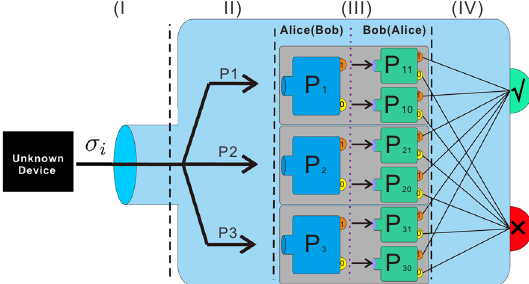
Fig. 1 Diagram of adaptive QSV with LOCC. The fi gure represents the general procedure to implement an adaptive QSV to verify whether an unknown source generates a pure target state. The generated states σ 1 , σ 2 , σ 3 , … , σ n are projected fi rstly by Alice with a randomly selected measurement setting Π i , with a prior probability as P i . The measurement on Bob ’ s side depends on the outcome of Alice ’ s measurement, i.e., if the outcome of Π i is 0 (1), Bob performs measurement Π i 0 ( Π i 1 ) accordingly. Bob ’ s outcome 1 and 0 are coarse-grained as accepted ( √ ) and rejected (×) events,